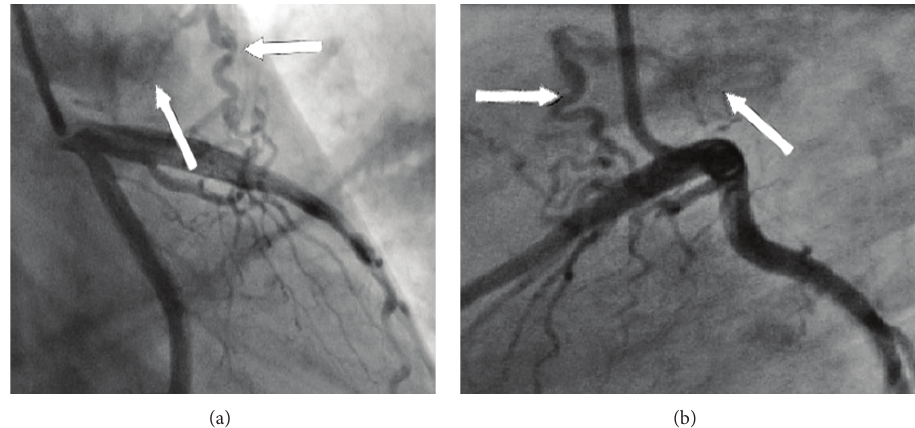
Figure1:Two branches originating fromleft anteriordescending coronaryartery (LAD)andthefirstdiagonal (DI)arecombining witha joint path and fistulizing to the pulmonary artery. (a) Right anterior oblique caudal. (b) Lateral view. Thin arrow: fistula; bold arrow: pulmonary